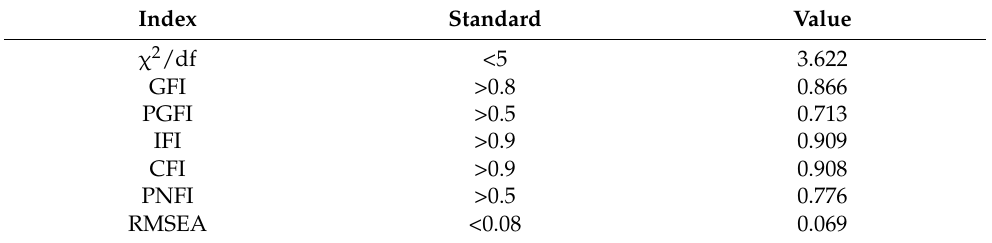
Table 5. Model fit index.